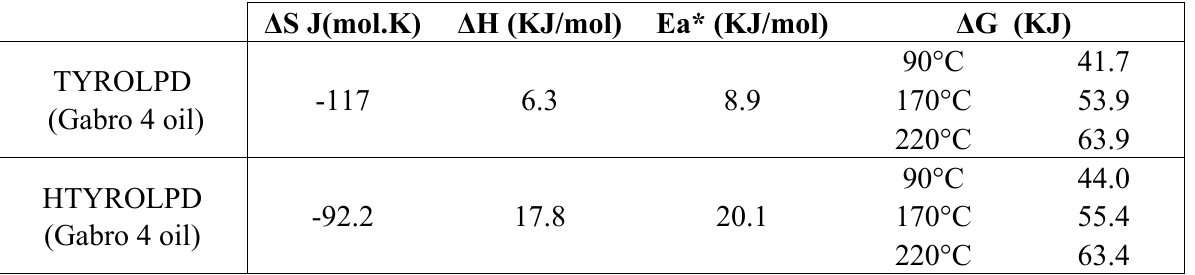
Table 3. The activation energy, Ea * , the activation enthalpy ( Δ H) and entropy ( Δ S) for Tyr-OLPD and